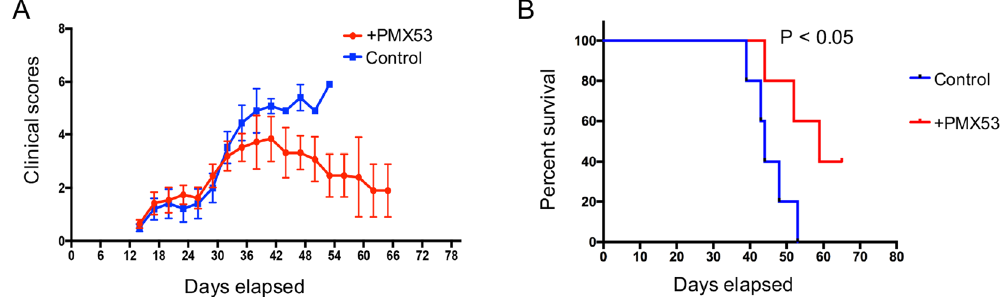
Figure 3. PMX53 treatment promoted the survival of cGVHD mice. ( A ) The clinical scores of cGVHD were reduced in the PMX53 treatment group, especially in the late stage of disease. ( B ) The survival rate data revealed that PMX53 treatment protected the cGVHD mice from death, and more mice lived longer. At least five mice were used in each group (N =